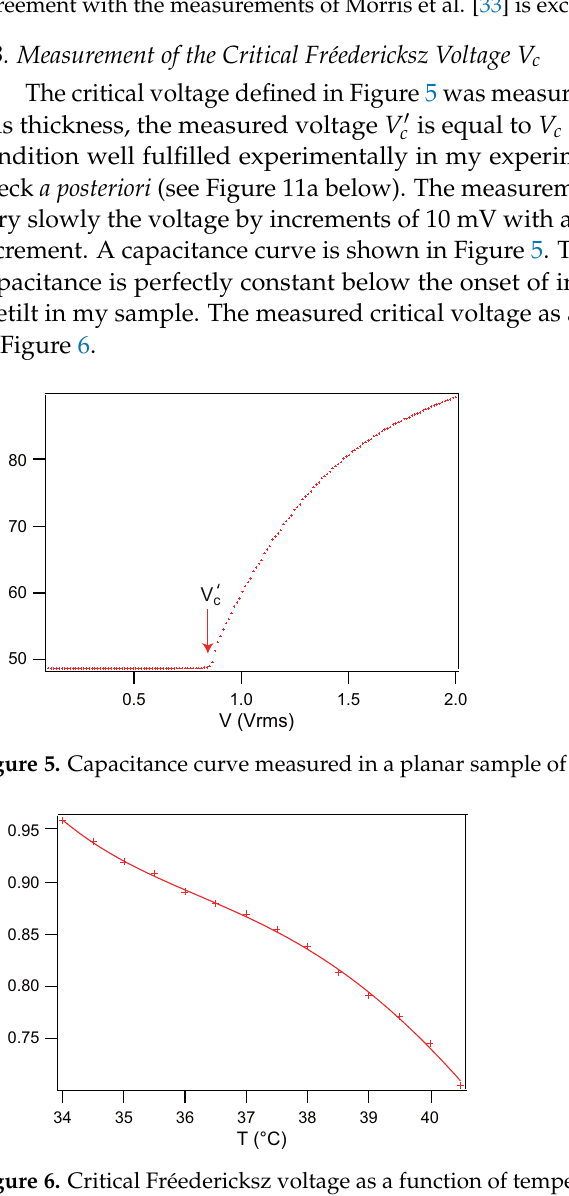
Figure 4. Dielectric anisotropy γ calculated by taking the value of ε (cid:107) extrapolated at V = 0 V. The agreement with the measurements of Morris et al. [33] is excellent.